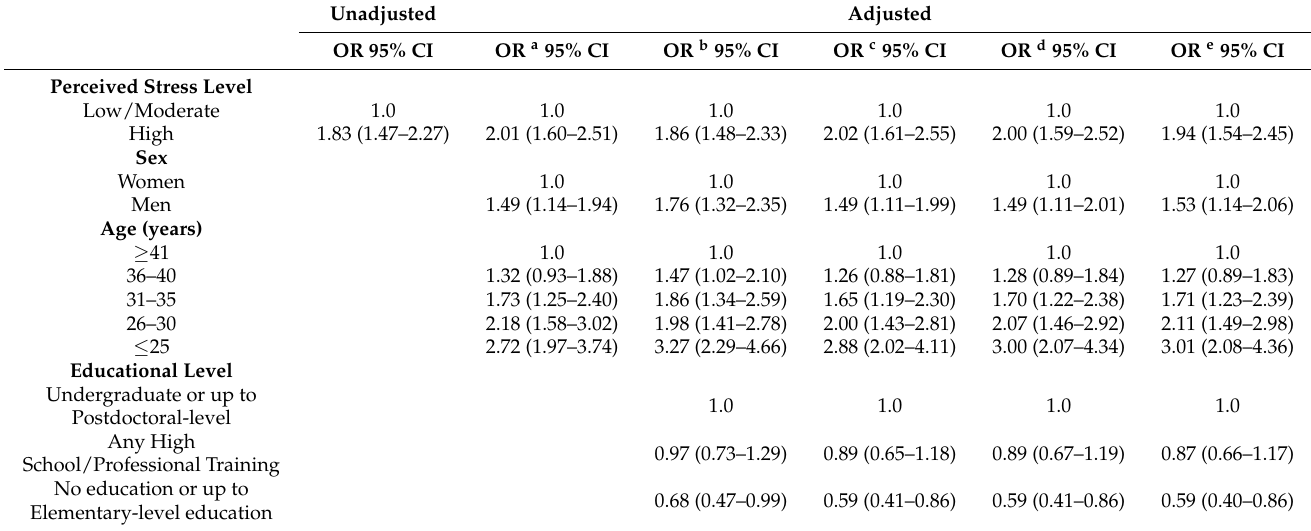
Table 3. Associations between ultra-processed food consumption and perceived stress levels in workers.